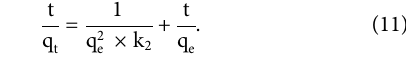
FIGURE 8 Potential energy surface relating to the absorption processes of quetiapine by the polymer matrix calculated by the B3LYP quantum chemical